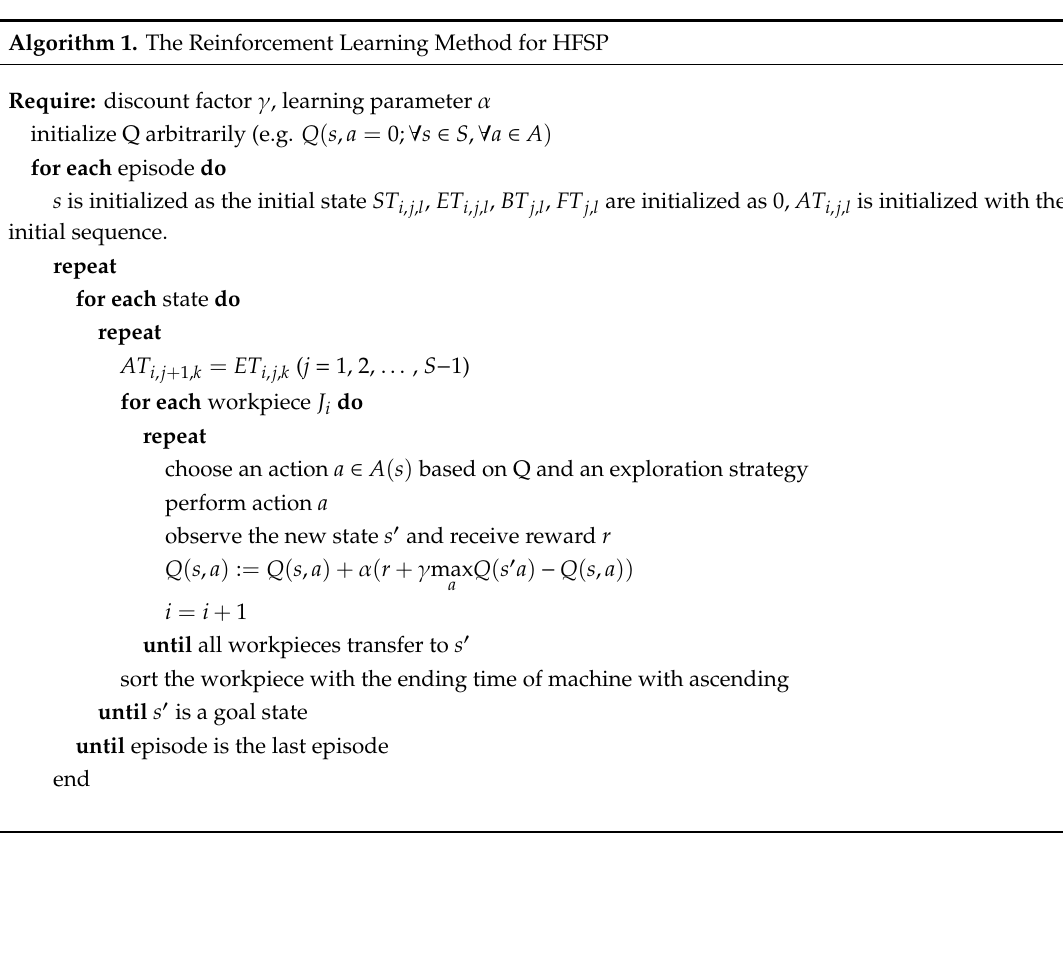
Algorithm 1. The Reinforcement Learning Method for HFSP Require: discount factor γ , learning parameter